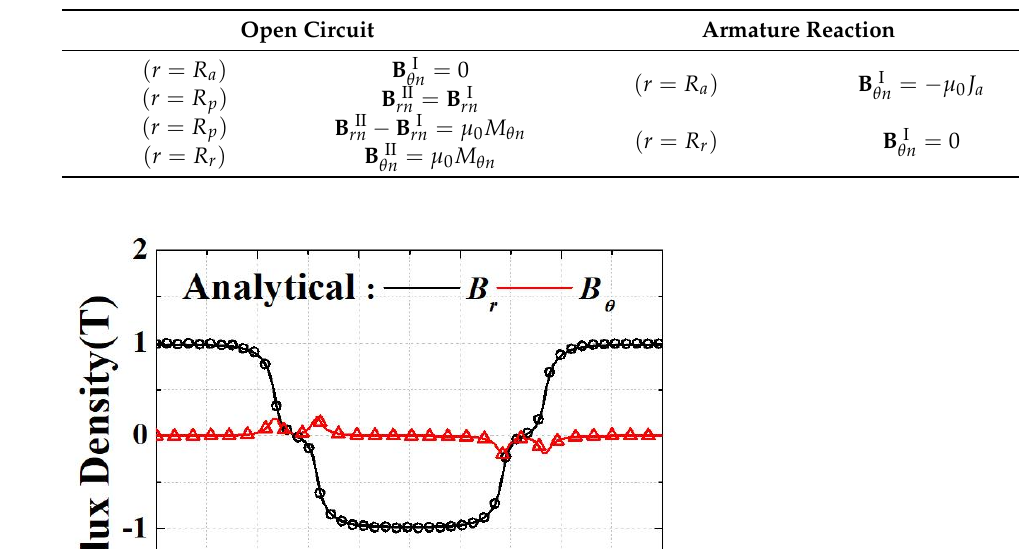
Table 3. Boundary conditions for deriving undefined coefficients.